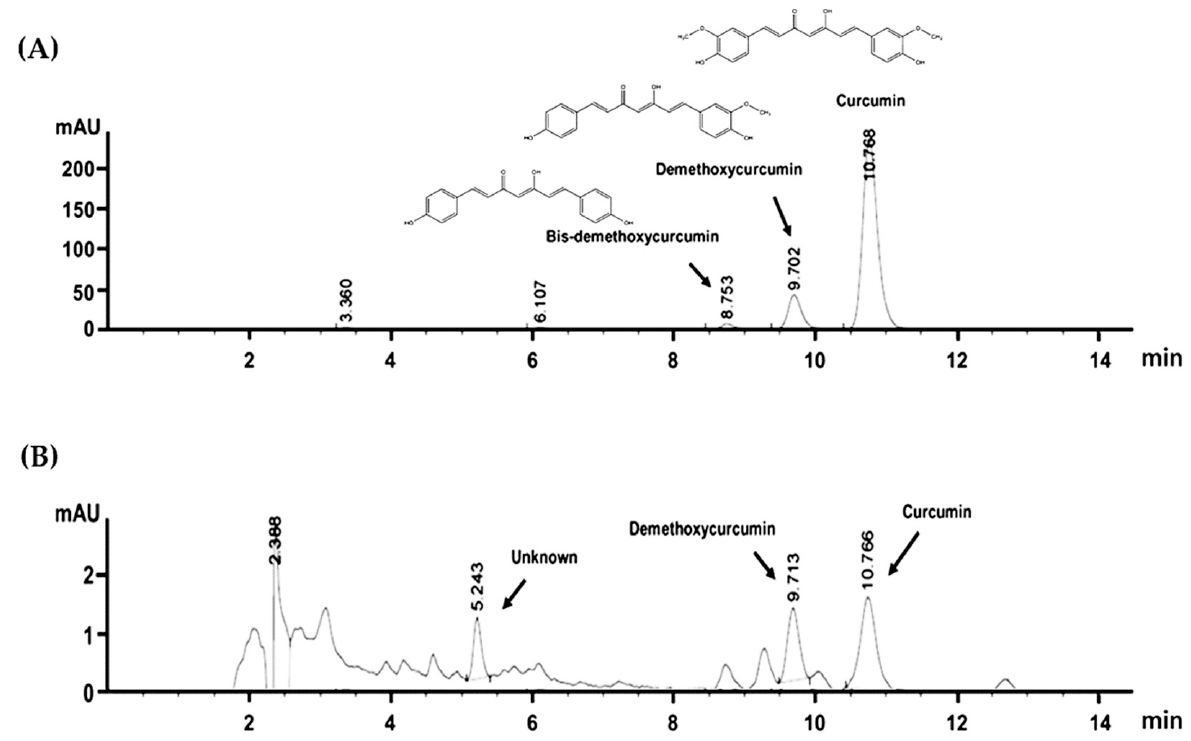
Figure 1. The HPLC profile of ( A ) curcuminoids (50 µ g/mL) including bis-demethoxycurcumin, desmethoxycurcumin, and curcumin with their chemical structures. ( B ) The HPLC profile of Curcuma amarissima extract (20 mg/mL) indicating the existence of desmethoxycurcumin and curcumin.